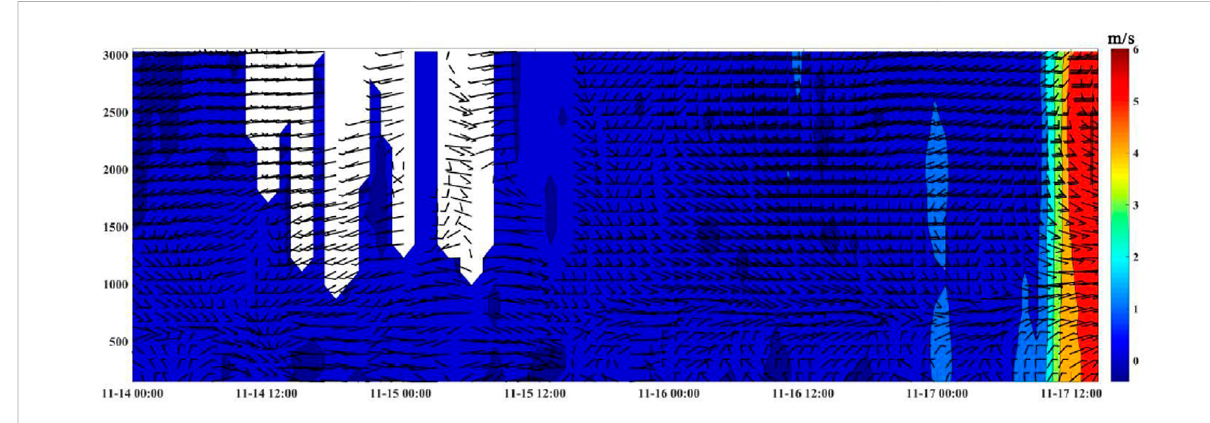
Time series of wind pro fi ler data with atmospheric vertical motion